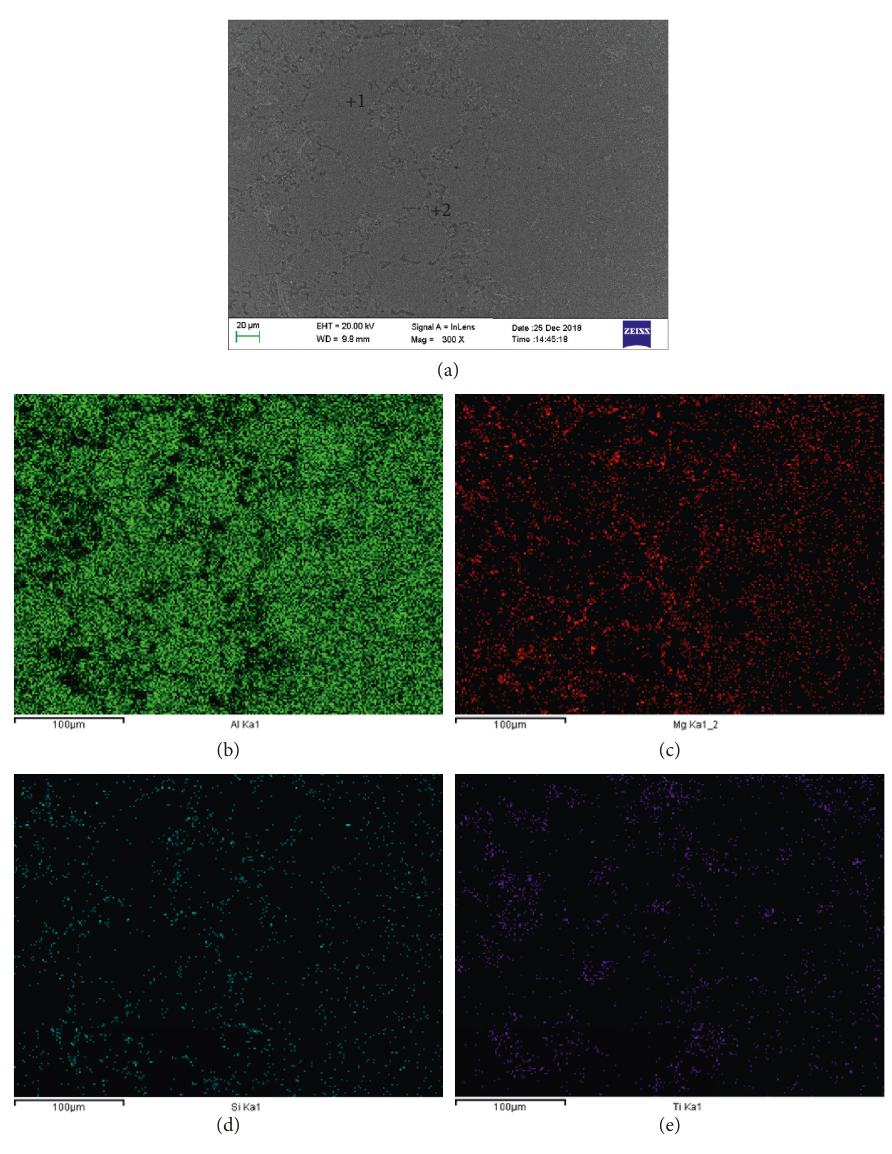
Figure 3: Map of the